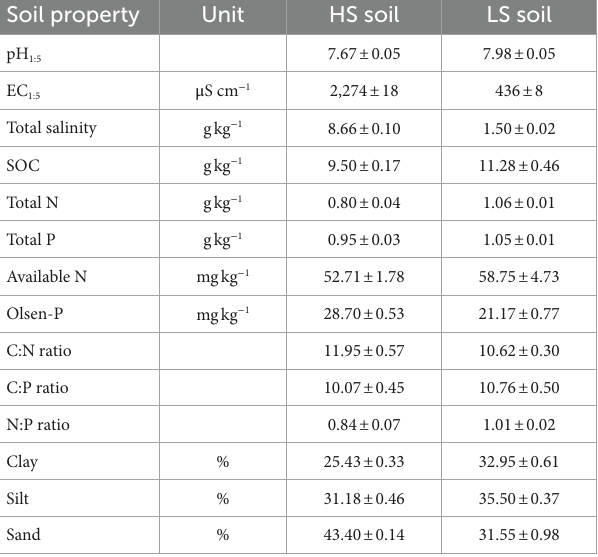
TABLE 1 Basic soil properties in high-salinity (HS) and low-salinity (LS) soil. Soil